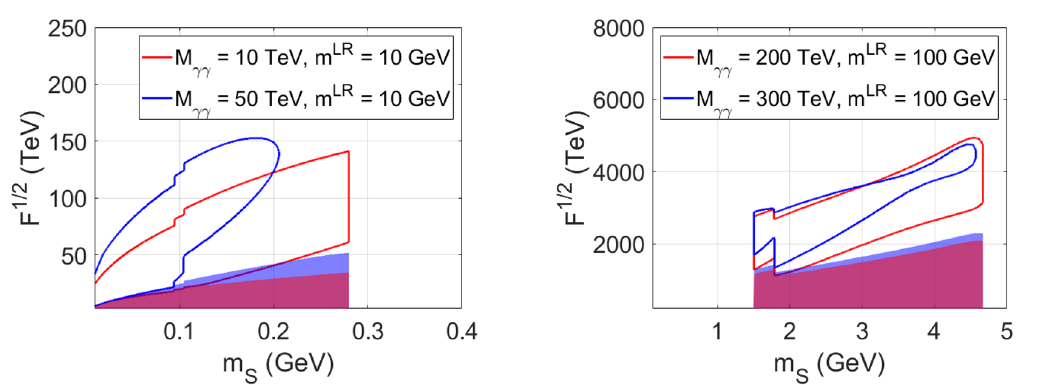
Figure 14 . Sensitivity region of FASER-II to models with sgoldstino flavor-violating couplings to quarks. Sgoldstinos are produced in decays of charm mesons (left panel) and beauty mesons (right panel). Shaded areas correspond to restrictions from table 1. At points where √ M γγ = F